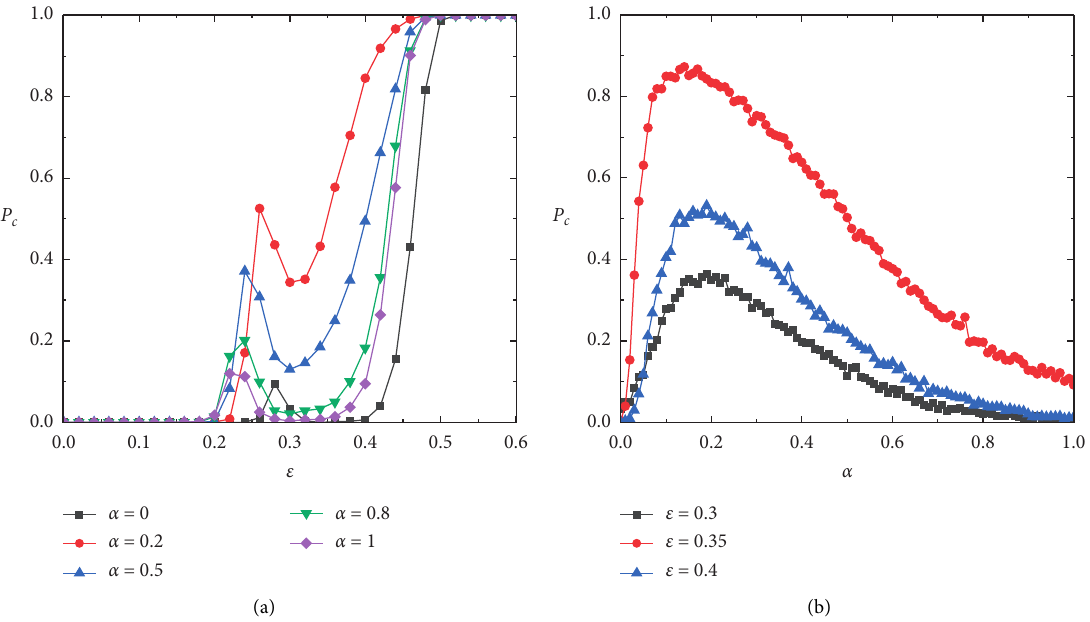
Figure 6: The results for the model on ER random networks (the average degree 〈 k 〉 � 20). (a) The probability of complete consensus P function of ε at α � 0 , 0 . 2 , 0 . 5 , 0 . 8, and 1. (b) The probability of complete consensus P c as a function of α at ε � 0 . 3 , 0 . 35, and